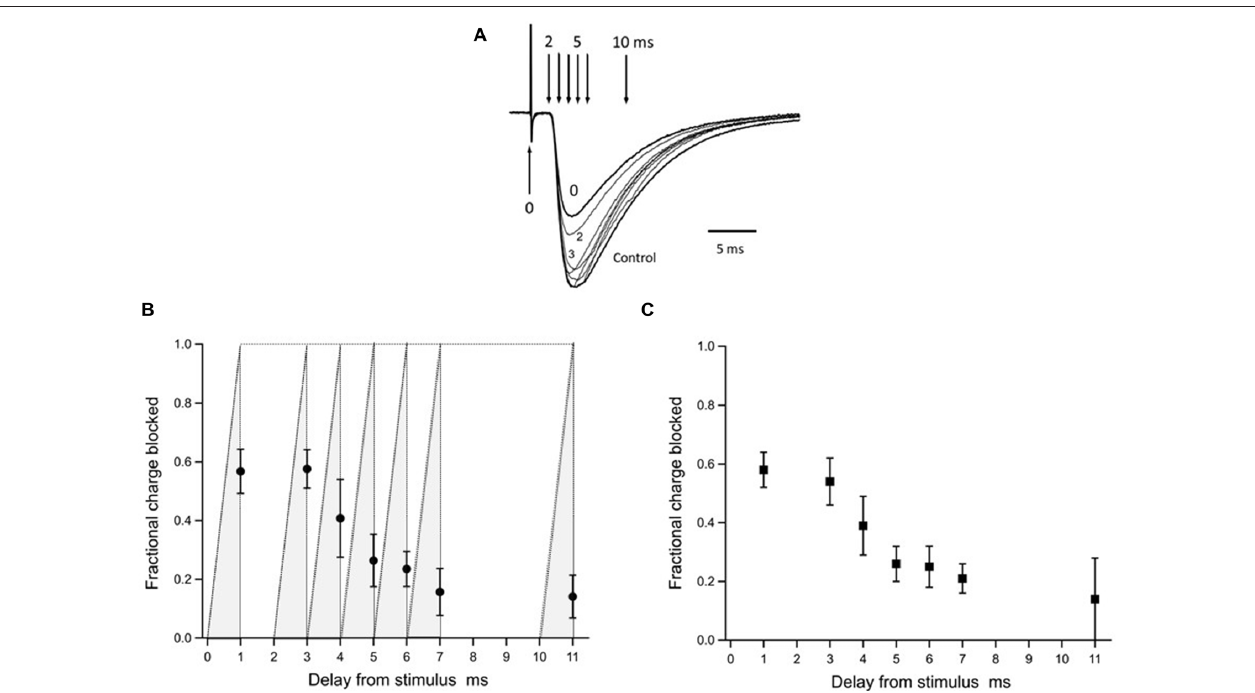
FIGURE 6 | Inhibition by γ - D GG photoreleased during the EPSC: estimating the timing of the synaptic transmitter transient. Panel (A) shows the EPSCs presented in Figure 5 superimposed for comparison of the time-course; the record obtained by release of γ - D GG between 0 and 1 ms, coincident with the stimulus, is marked 0; records corresponding to release over 2–3 ms and 3–4 ms post-stimulus are labeled 2 and 3 respectively. Vertical arrows indicate the trigger timing of photolysis pulses releasing γ - D GG as delay times from the stimulus. Panel (B) summarizes data from 4 to 8 cells of the fraction of total synaptic charge blocked by γ - D GG. Data are Mean ± SD plotted at the end of the 1 ms photolysis pulse. The integration of the light pulse is indicated by the gray shading for each data point and represents the time-course of γ - D GG concentration increase during the flash, uniform over the microscope field. To obtain the fractional charge blocked by γ - D GG test EPSCs were integrated over 60 ms following the stimulus, subtracted from and normalized to the integral of control EPSCs recorded 30 s earlier. MNI-caged- γ - D GG concentration range 2.7–5.9 mM, γ - D GG released range 0.34–0.74 mM. Panel (C) to quantify γ - D GG fractional block late in the EPSC, integrations were made from the time of the flash to 60 ms, subtracted from and normalized to the same period in control. To control for the proton current artifact a record was taken with the flash but without stimulation and subtracted from the test records obtained with stimulation. As a further check the records in (C) were integrated from 1 ms after the flash, requiring no subtraction of initial current. Results with or without subtraction were similar. Animal ages 13 days in (A) , 13–14 days in (B,C) . Temperature 21–24 ◦